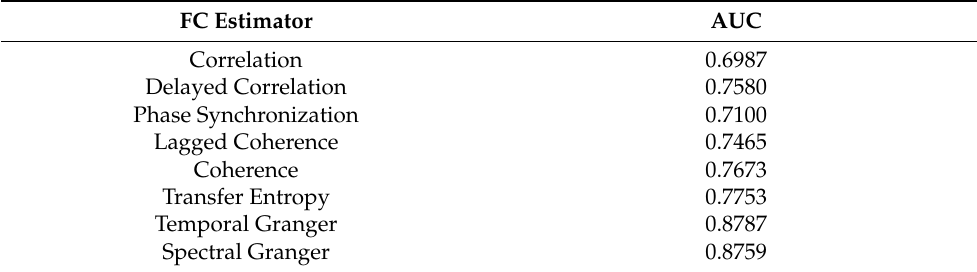
Figure 4. ROC curves ( a ) and precision–recall curves ( b ) obtained with the different FC estimators using the data obtained from 100 randomly generated connectivity networks among the four ROIs. The area under the ROC curve for each estimator is reported in Table 1. Table 1. The different FC